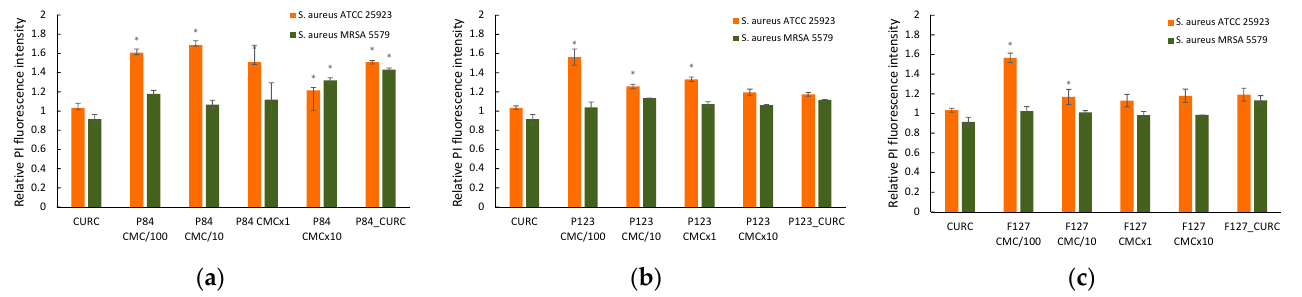
Figure 8. Relative PI fluorescence in S. aureus cultures incubated with micellar and unassociated molecules of Pluronic derivatives: Pluronic P84 ( a ); Pluronic P123 ( b ); Pluronic F127 ( c ). The con- centration of Curcumin solubilized in DMSO and in polymeric micellar dispersion is 100 μ M. Con- centrations of Pluronic derivatives were selected according to their CMC values (Table 1) to cover the micellar domain (concentrations equal to CMC and 10-fold higher) and unimer domain (con- cetrations equal to CMC/100 and CMC/10).